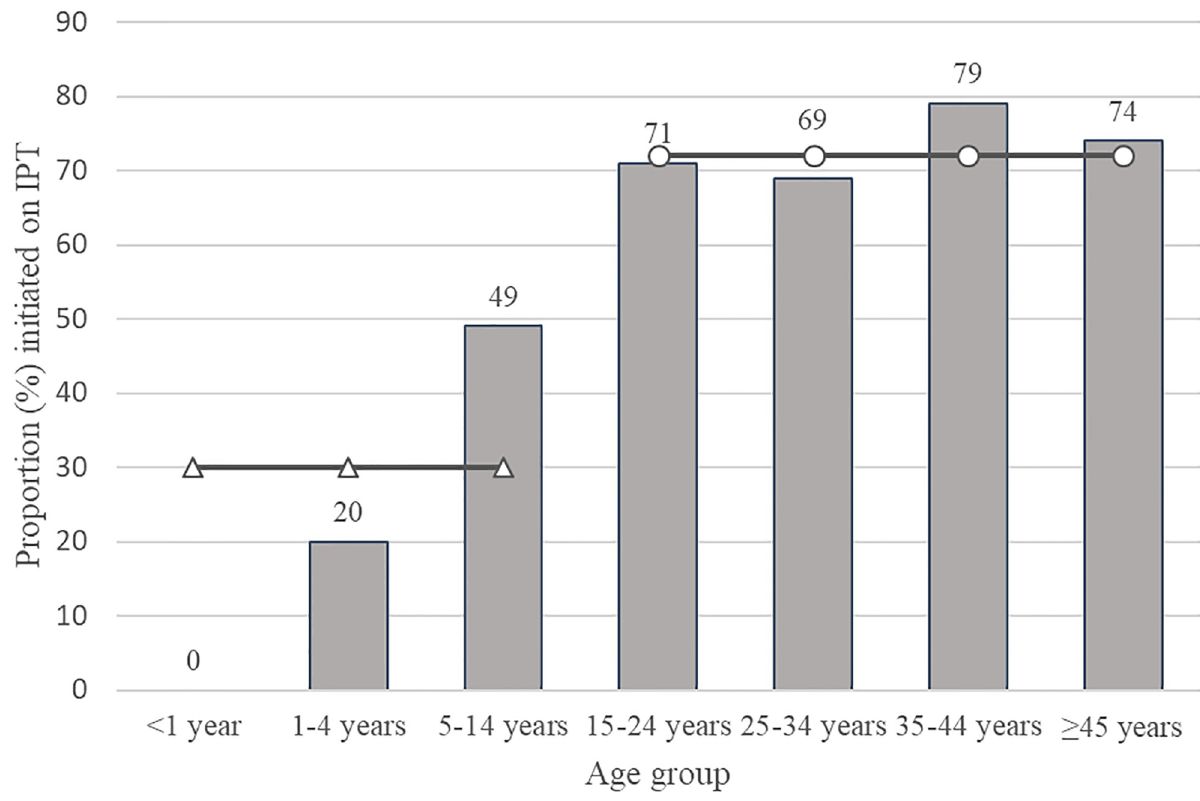
Fig 3. Weighted proportion of isoniazid preventive therapy (IPT) initiated among eligible people living with HIV (PLHIV) newly enrolled in antiretroviral therapy by age group in two urban areas of Malawi (2017). Age group-specifc IPT initiations; IPT initiations among PLHIV aged < 15 years; IPT initiations among PLHIV aged � 15